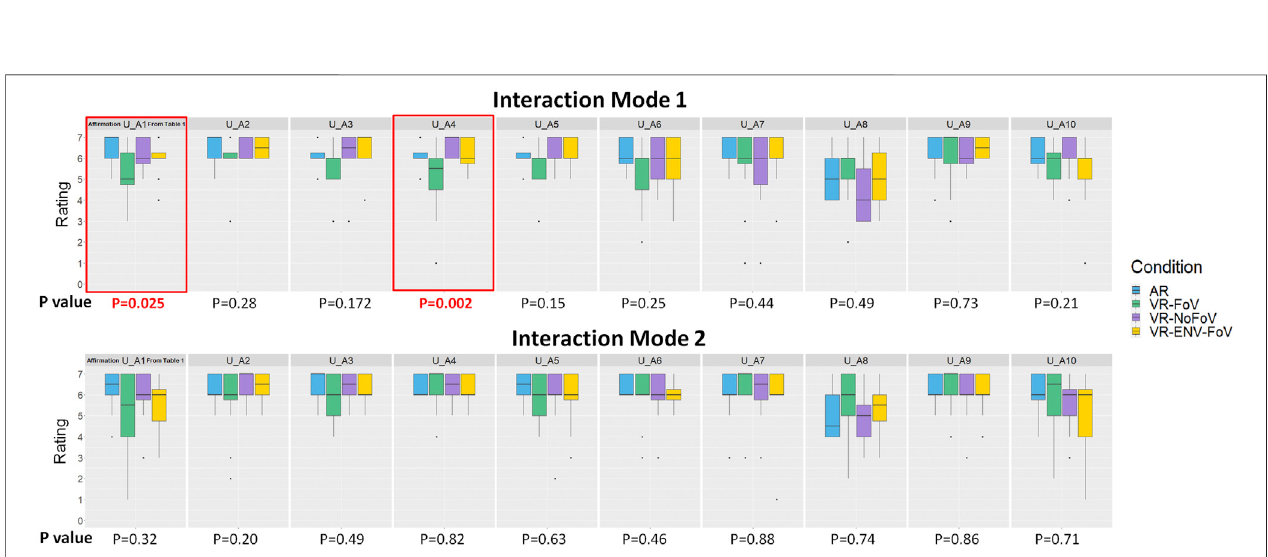
FIGURE 8 | Ratings given to each statement of Table 1 collected for both interaction modes. p -values for these factors are the result of independent ANOVAs.